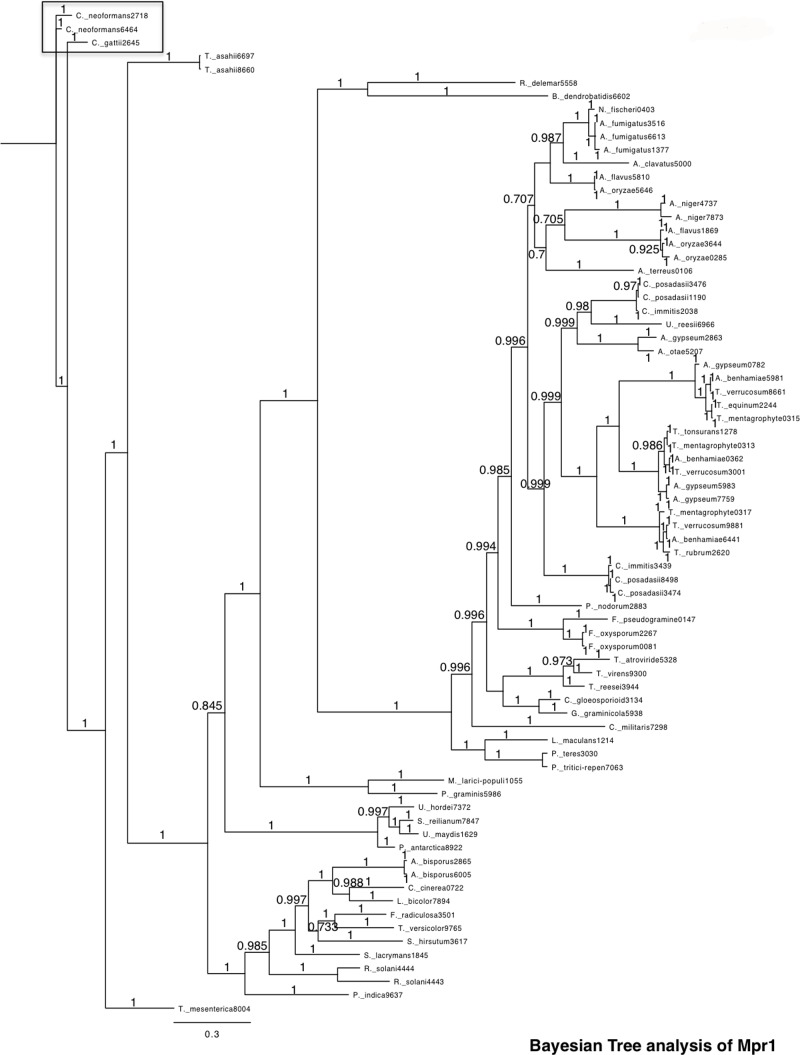
The MrBayes majority-rule consensus tree reveals a distinct phylogenetic relationship between Cryptococcal Mpr1 and other M36 family members.The MrBayes tree is based on ClustalW2 amino acid sequence alignments of CnMPR1 and other M36 family members and obtained from searching the HMMER web server (hmmer.janelia.org). The Bayesian tree reveals a distinct phylogenetic relationship between Mpr1 in Cryptococcus species and M36 family members in other fungi. An Mpr1 homolog was identified in the closely related basidiomycete Tremella mesenterica, however, Mpr1 clusters separately from the rest of the M36 family. Posterior probability values are shown as node labels. Well supported nodes indicated by a “1” with maximum likelihood bootstrap (BS) support >80.